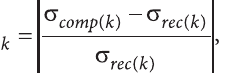
Table 4. Average stress estimation errors Source